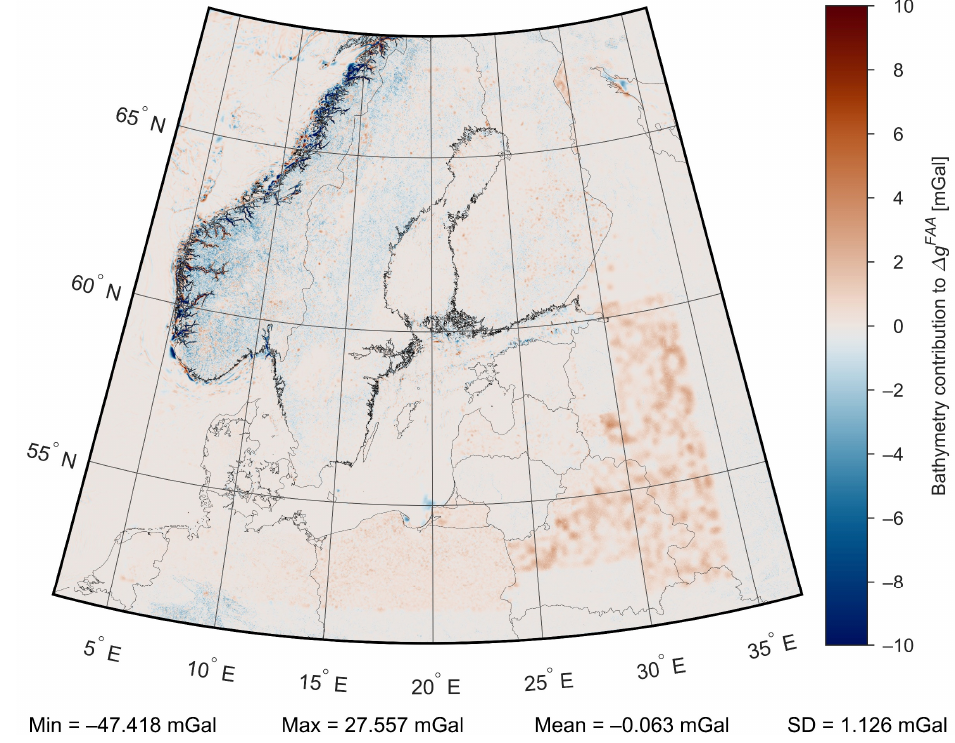
Figure 11. Bathymetry contribution to gridded surface free-air anomalies.